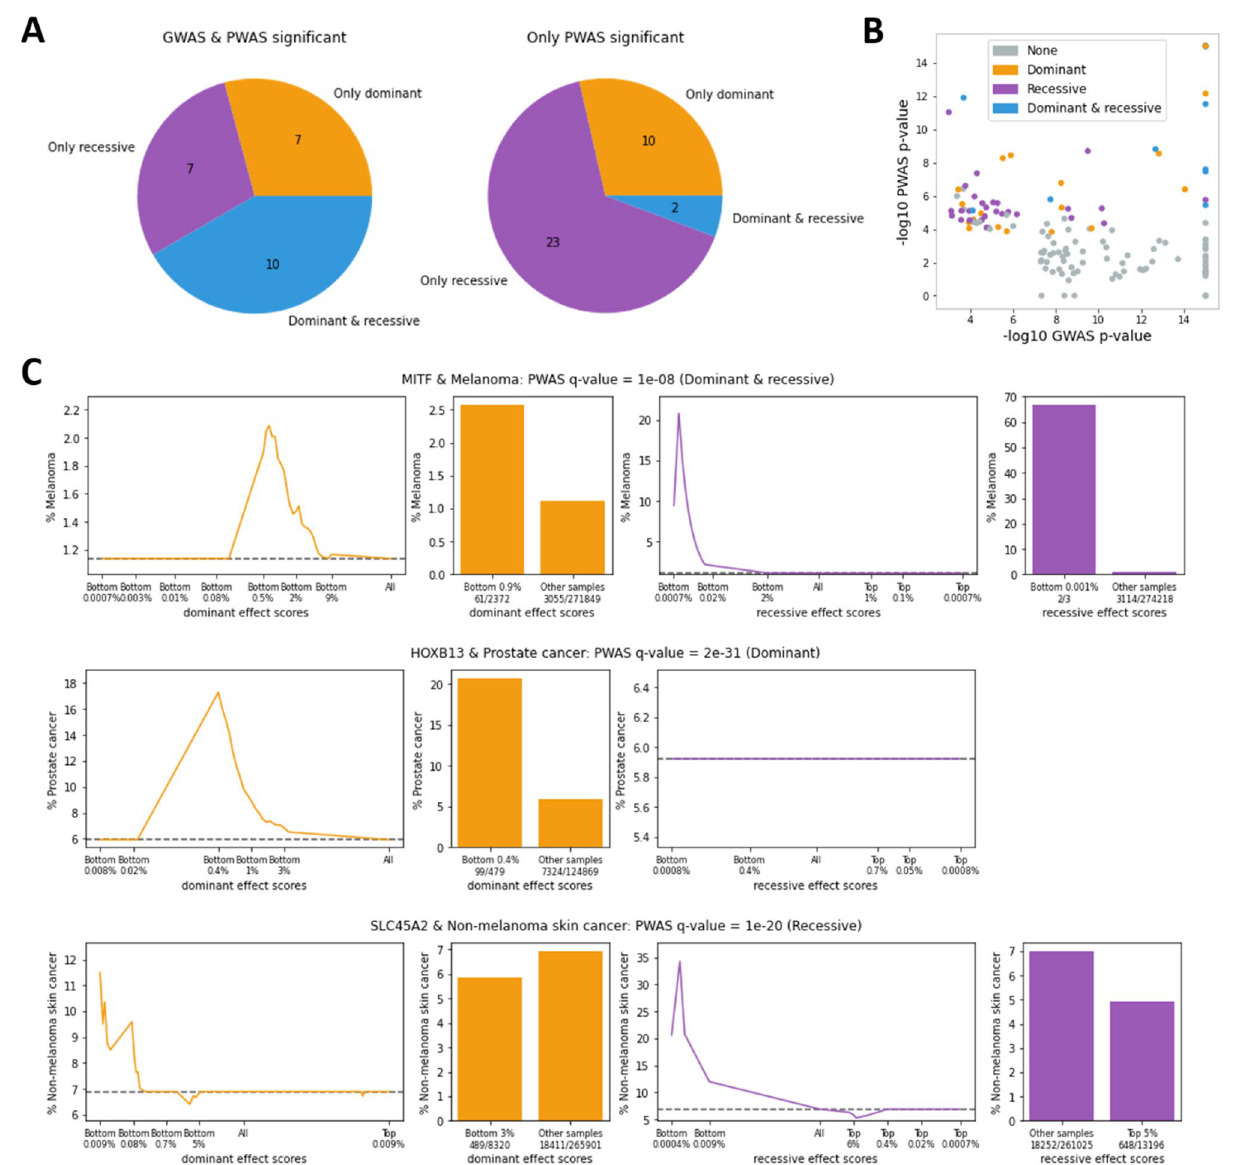
Figure 6. Dominant and recessive gene effects. ( A ) Partitioning of the significant cancer genomic regions that are PWAS-significant according to their inheritance mode (dominant, recessive or both), and whether they are also significant by GWAS. ( B ) GWAS and PWAS p -values (capped at 1E-15) across all 145 significant caner genomic regions. Regions are color coded by whether they were found significant by the dominant model of PWAS, the recessive one, both, or none. ( C ) Three examples of significant PWAS associations: MITF and melanoma, HOXB13 and prostate cancer, and SLC45A2 and non-melanoma skin cancer. The plots show how risk for the relevant cancer types changes as a function of PWAS effect scores in the UKB cohort. Dominant effect scores (orange) aim to capture the likelihood of an individual to have at least one damaged copy of the gene, whereas recessive effect scores (purple) aim to capture the likelihood of at least two damaged copies. In both types of PWAS effect scores, lower scores reflect individuals with greater gene damage. The line plots show a continuous partitioning of the cohort according to the dominant or recessive effect scores on the x-axis, and the estimated fraction of individuals with a history of the relevant cancer in each partition on the y-axis. For example, in the association between melanoma and the dominant effect scores of MITF (shown on the upper- left plot in (C)), “Bottom 0.5%” on the x-axis refers to the 0.5% of the cohort with the lowest dominant effect scores, namely the 0.5% of individuals that are the most likely to have at least one damaged copy of MITF. The prevalence of melanoma in that group is estimated at ~ 2%. The dashed horizontal line shows the baseline cancer risk across the entire cohort (1.14% cases for melanoma). The bar plots show the most significant partitioning of individuals. For example, among the 0.9% (2,372) of the individuals with the lowest dominant effect scores calculated for the MITF gene, 61 (2.57% of them) have had melanoma, compared to 1.12% rate of melanoma among the other individuals (3055 melanoma cases among 271,849 individuals). Note that the scales of the plots are not uniform. In particular, each plot shows a different partitioning of the cohort (based on the relevant distribution of effect